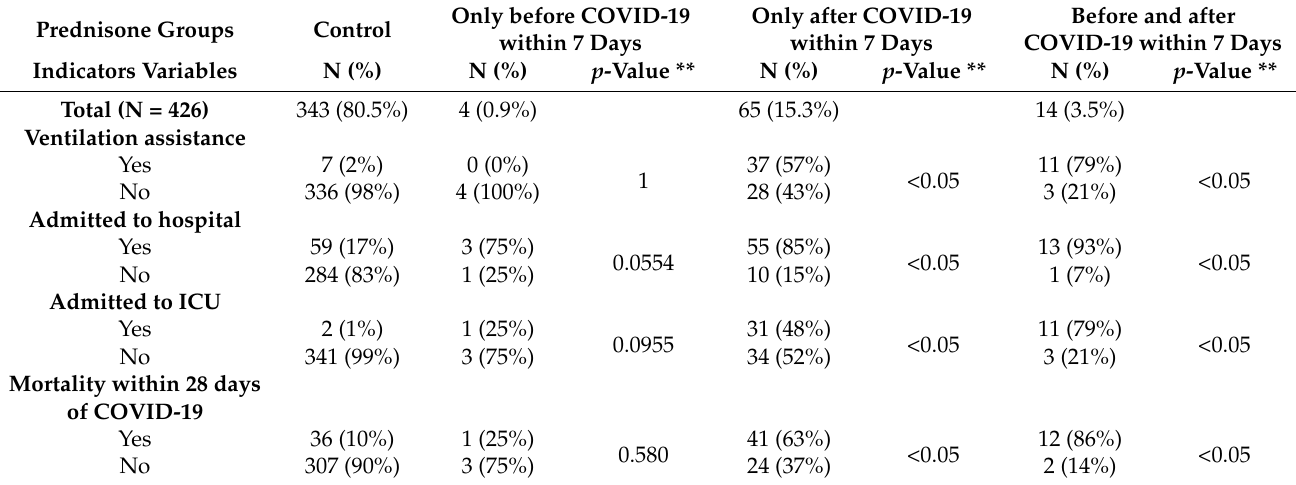
table are corrected for multiple testing using the Benjamini–Hochberg method. SD: standard deviation, IQR: interquartile